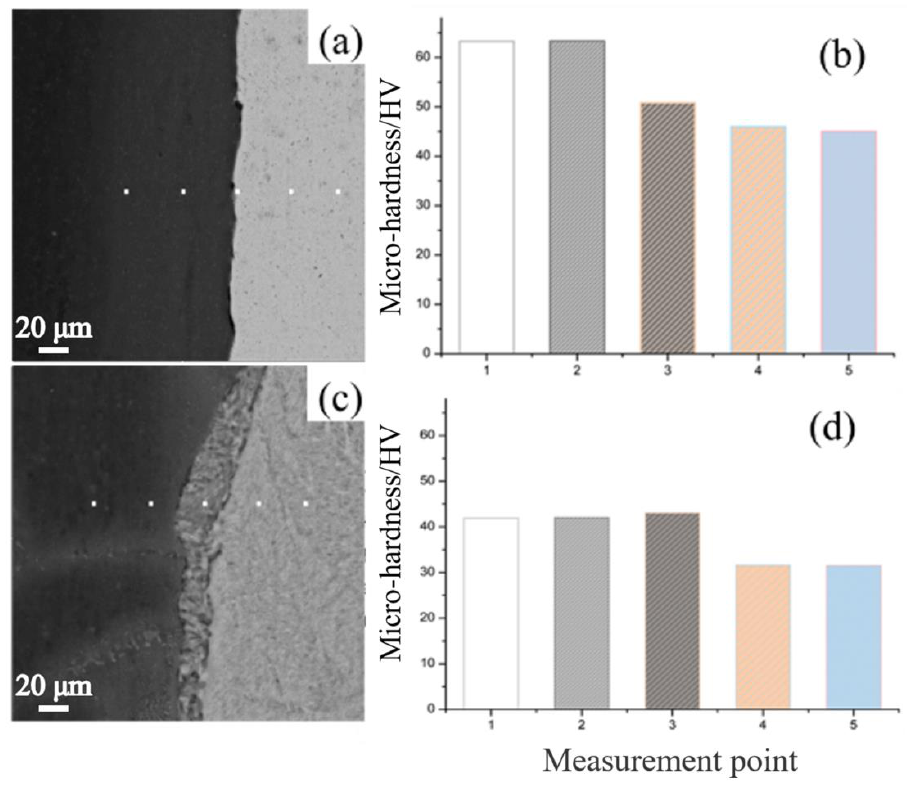
Figure 16. Micro-hardness of the interface test points in the rolled state ( a , b ) and that of the interface test points at 280 °C × 2 h ( c , d ).